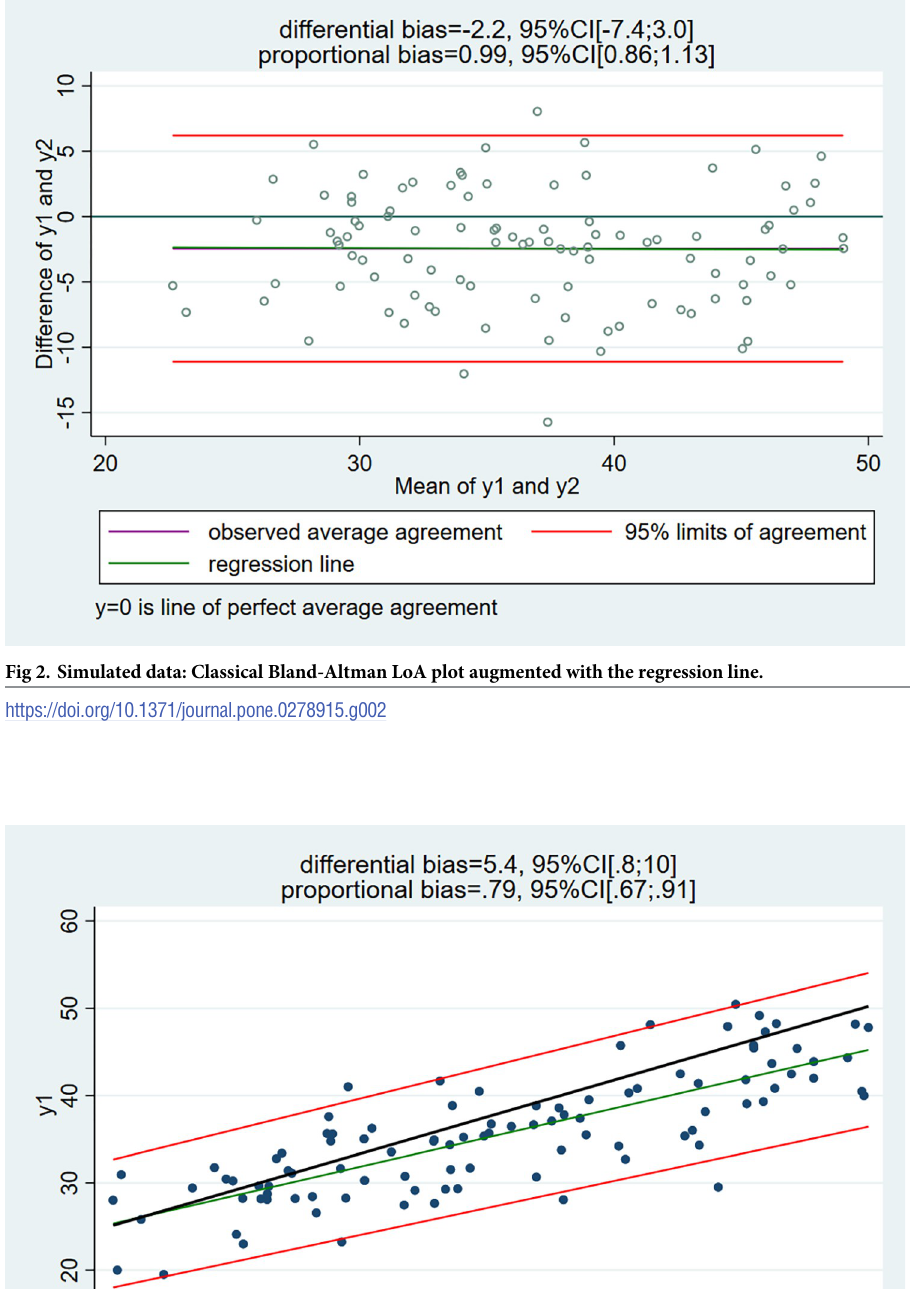
PLOS ONE | https://doi.org/10.1371/journal.pone.0278915 December12,